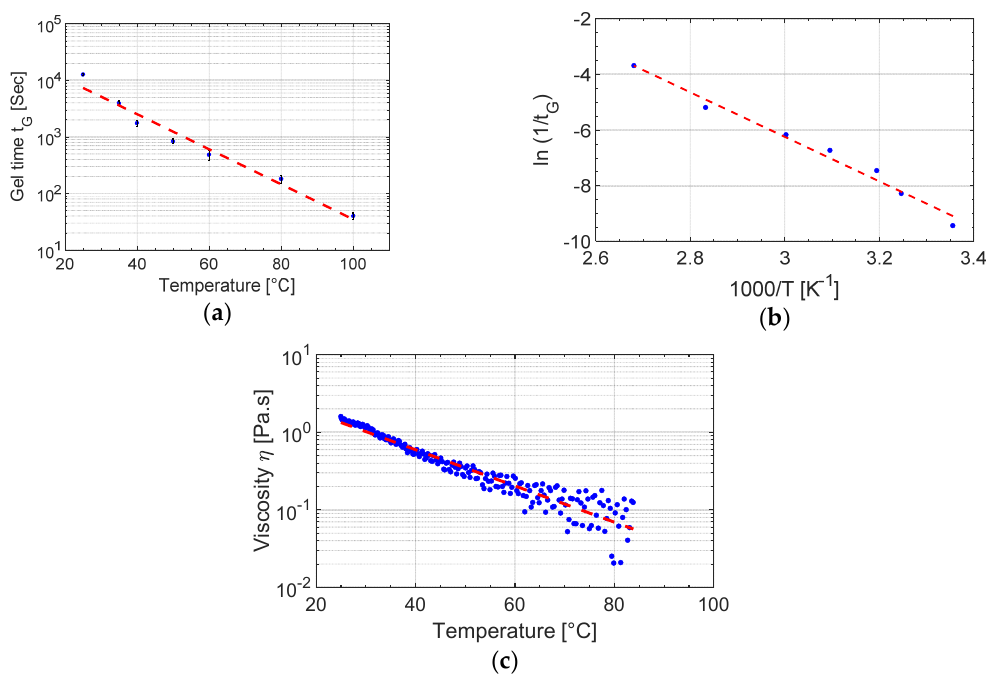
Figure 9. ( a ) change in gel time vs. temperature, ( b ) ln(1/ t G ) vs. 1000/ T and fitted line based on Equation (16), and ( c ) viscosity change as a function of temperature for UPR.